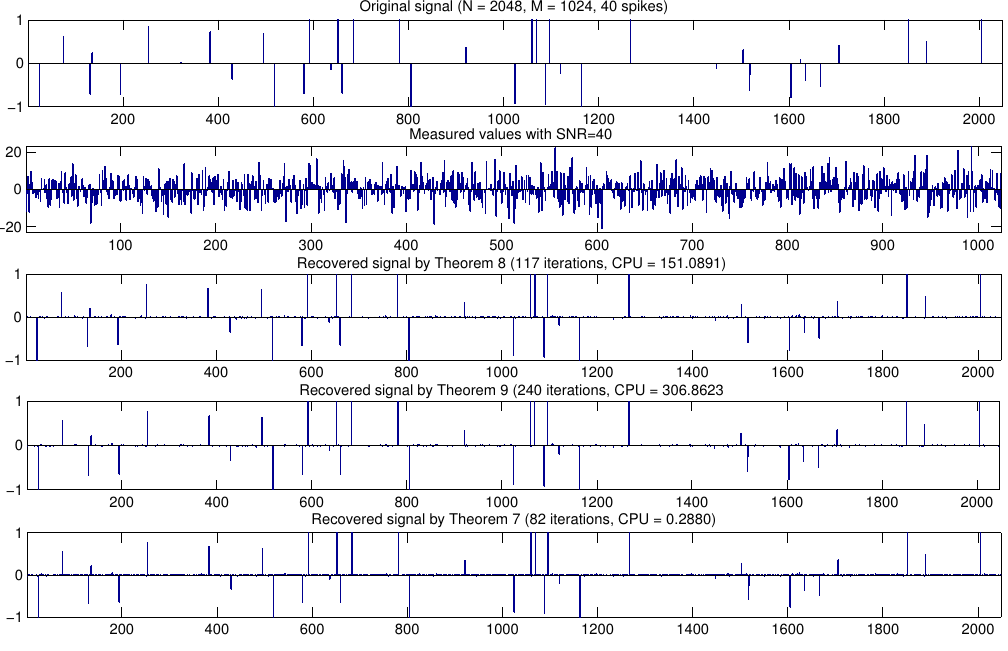
Figure 2. From top to bottom: original signal, measured values, recovered signal by Theorem 8, Theorem 9 and Theorem 7 with N = 2048, M = 1024 and m = 40.